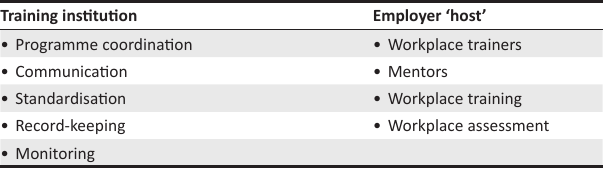
TABLE 1b: Responsibilities of different stakeholders in the learnership